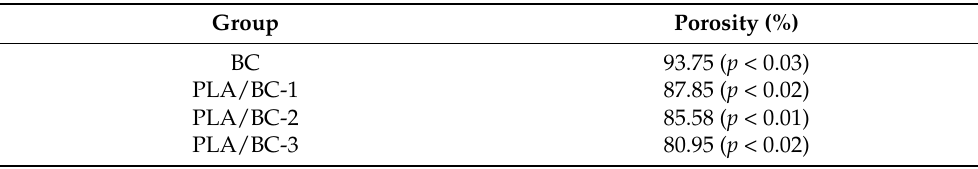
Table 1. Porosity of BC membrane and PLA/BC composite